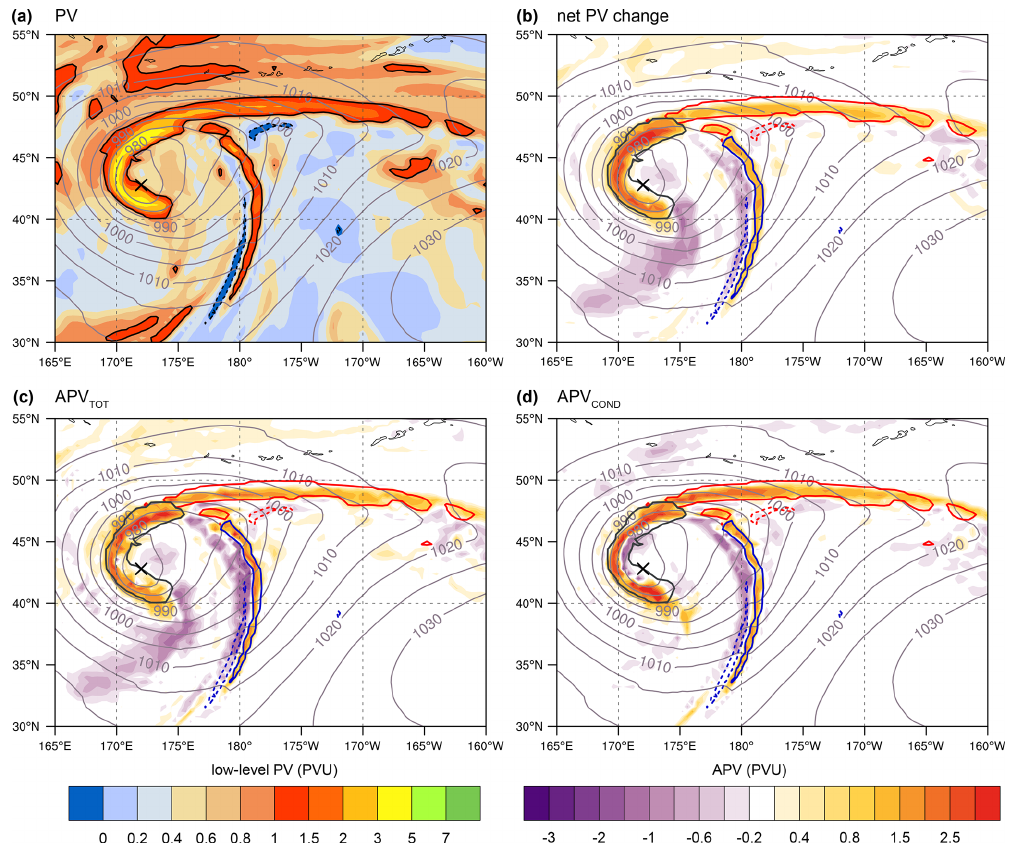
Figure 2. An extratropical cyclone over the North Pacific at the time of maximum intensification. (a) Vertically averaged PV between 840 and 780hPa. Regions with PV ≥ 1PVU and PV ≤− 0 . 1PVU are highlighted by solid and dashed black lines, respectively. (b) Net PV change, (c) total diagnosed PV modification, and (d) effect of condensation on PV along 15h backward trajectories. The positive and negative PV anomalies along the cold front (blue solid and dashed lines), the positive and negative PV anomalies along the warm front (red solid and dashed lines), and the positive PV anomaly in the cyclone center (dark gray solid line) are highlighted. SLP (gray contours) is overlaid at an interval of 5hPa, and the SLP minimum is marked by the